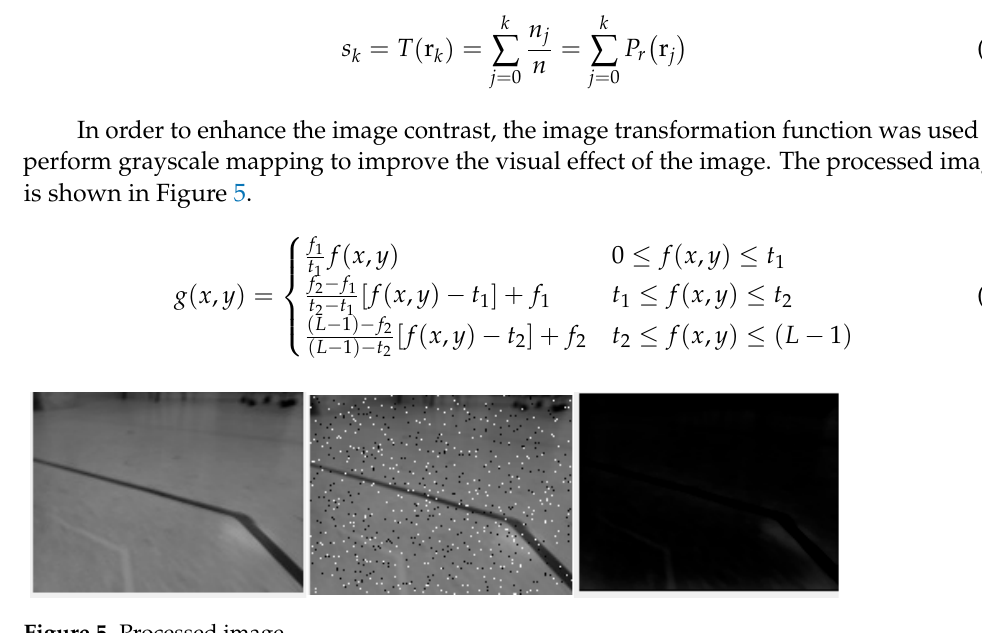
Figure 5. Processed image.